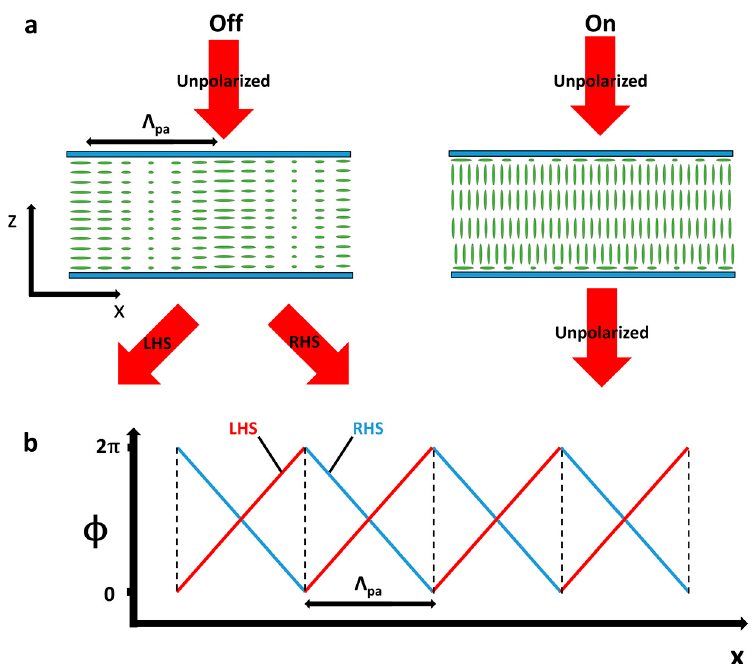
Figure 13. Shows a Pancharatnum–Berry beam deflector. ( a ) Shows the off and on states, respec- tively, where the light is deflected to the ±1 orders with close to 100% efficiency for each handed- ness or pass through, respectively. ( b ) Shows the OPD experienced by the two polarisations. LHS and RHS each experience a blazed grating in opposite directions, leading to close to 100% effi- ciency.